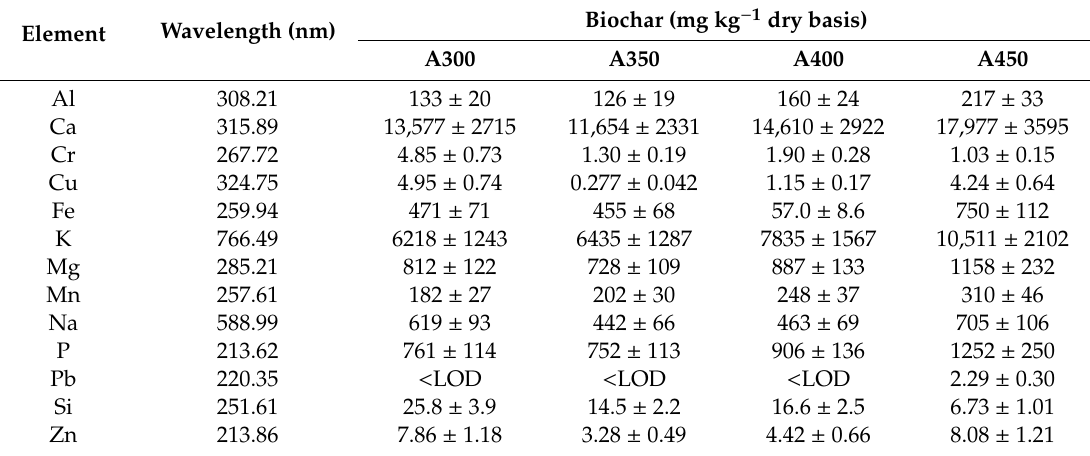
Table 3. Multi-elemental composition of